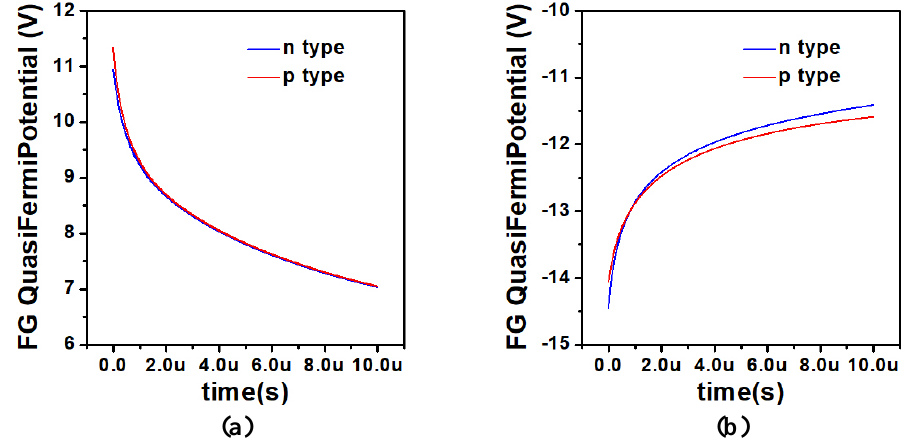
Figure 5. FG potential in UFGM as a function of time after ( a ) programming operation and ( b ) erasing operation using the operation voltage scheme in Table 2